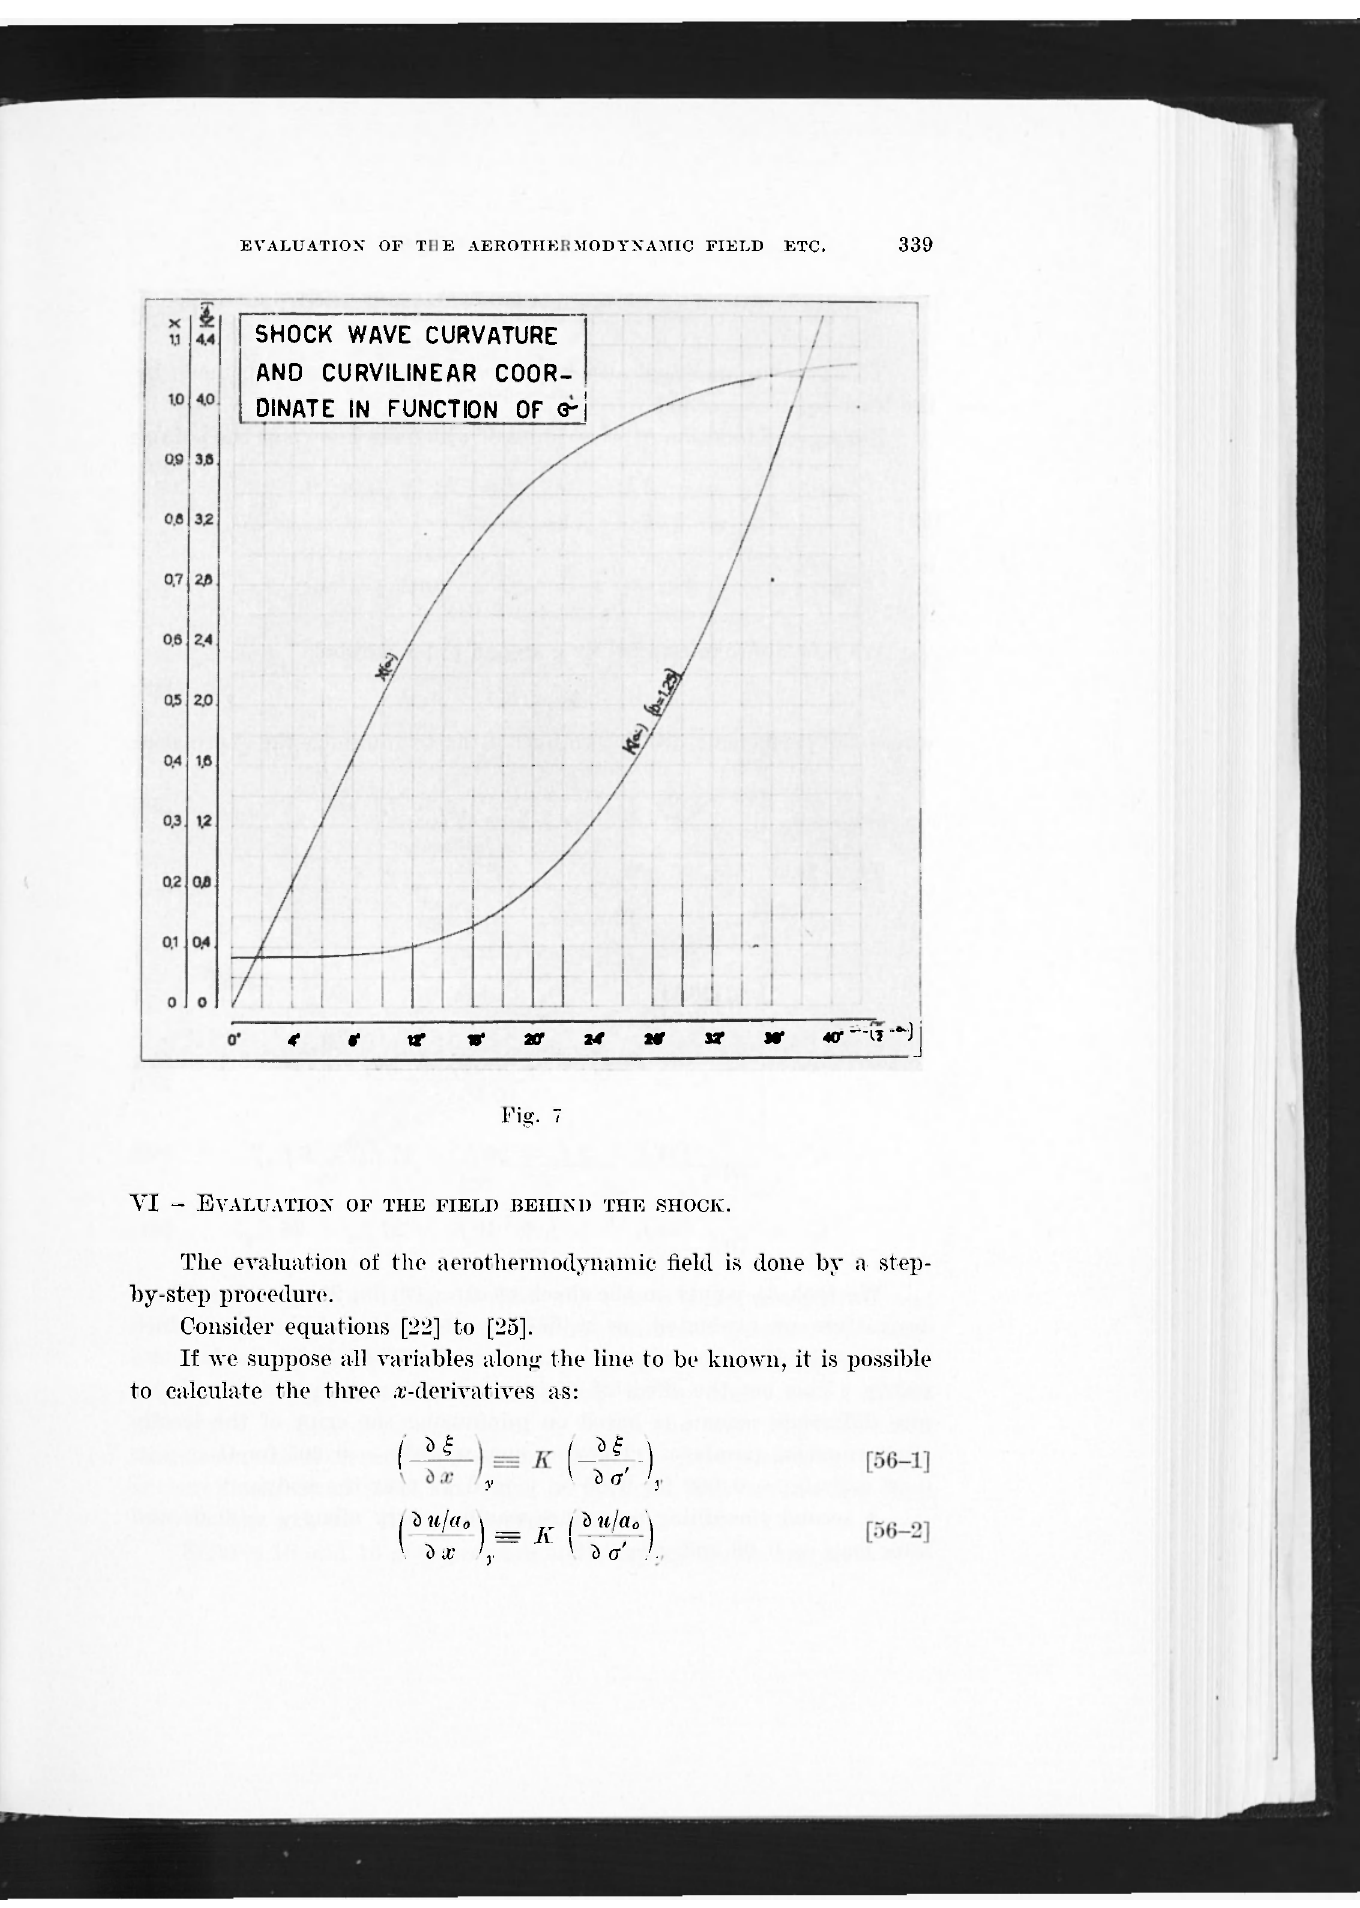
VI - EVALTJATION OF THE FIELI) BEICIXI) THE